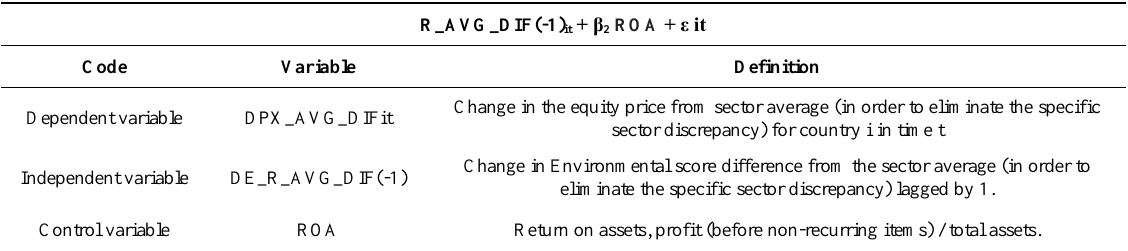
Table 5. OLS regression estimation (EViews